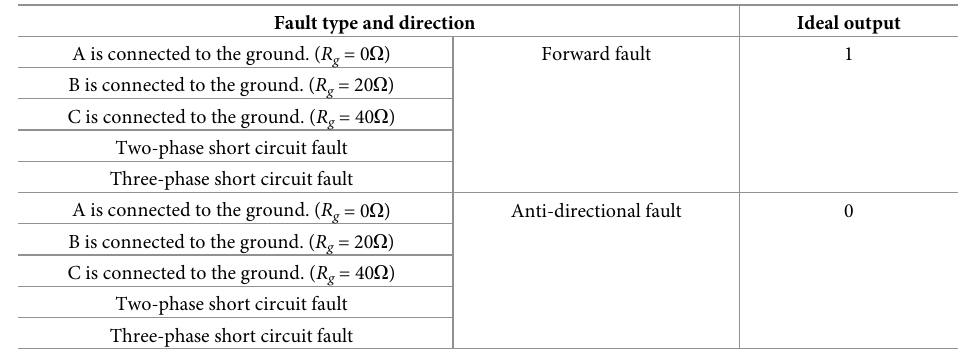
Table 1. ANN l training